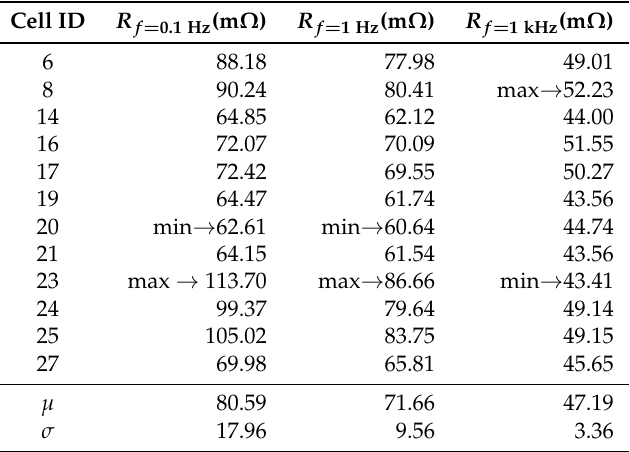
Table 2. Resistances of the recovered